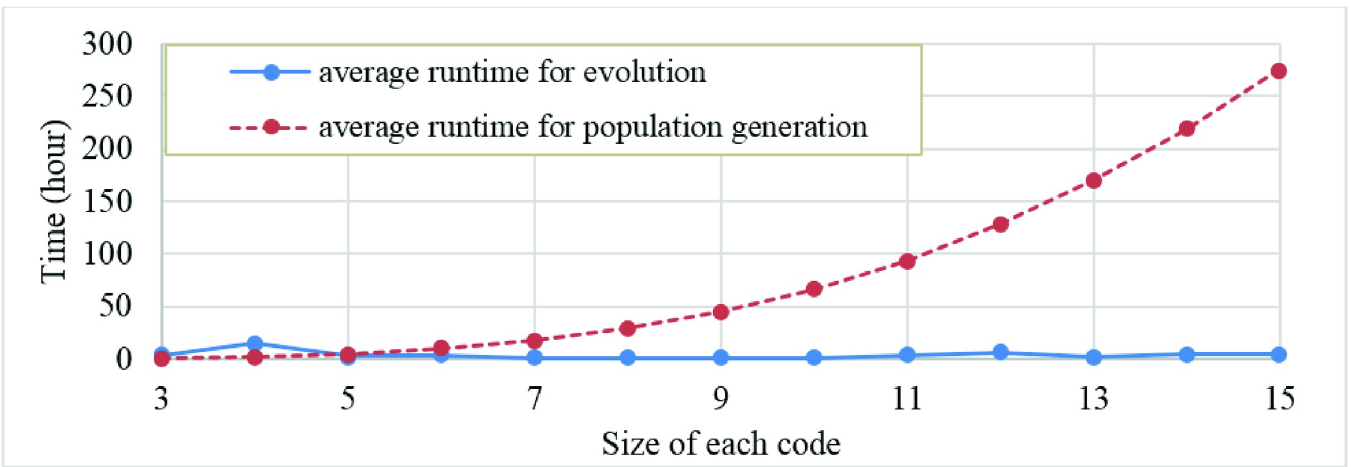
Fig 8. Evolution and generation runtimes during search for various sizes of zero-scored 2D code.